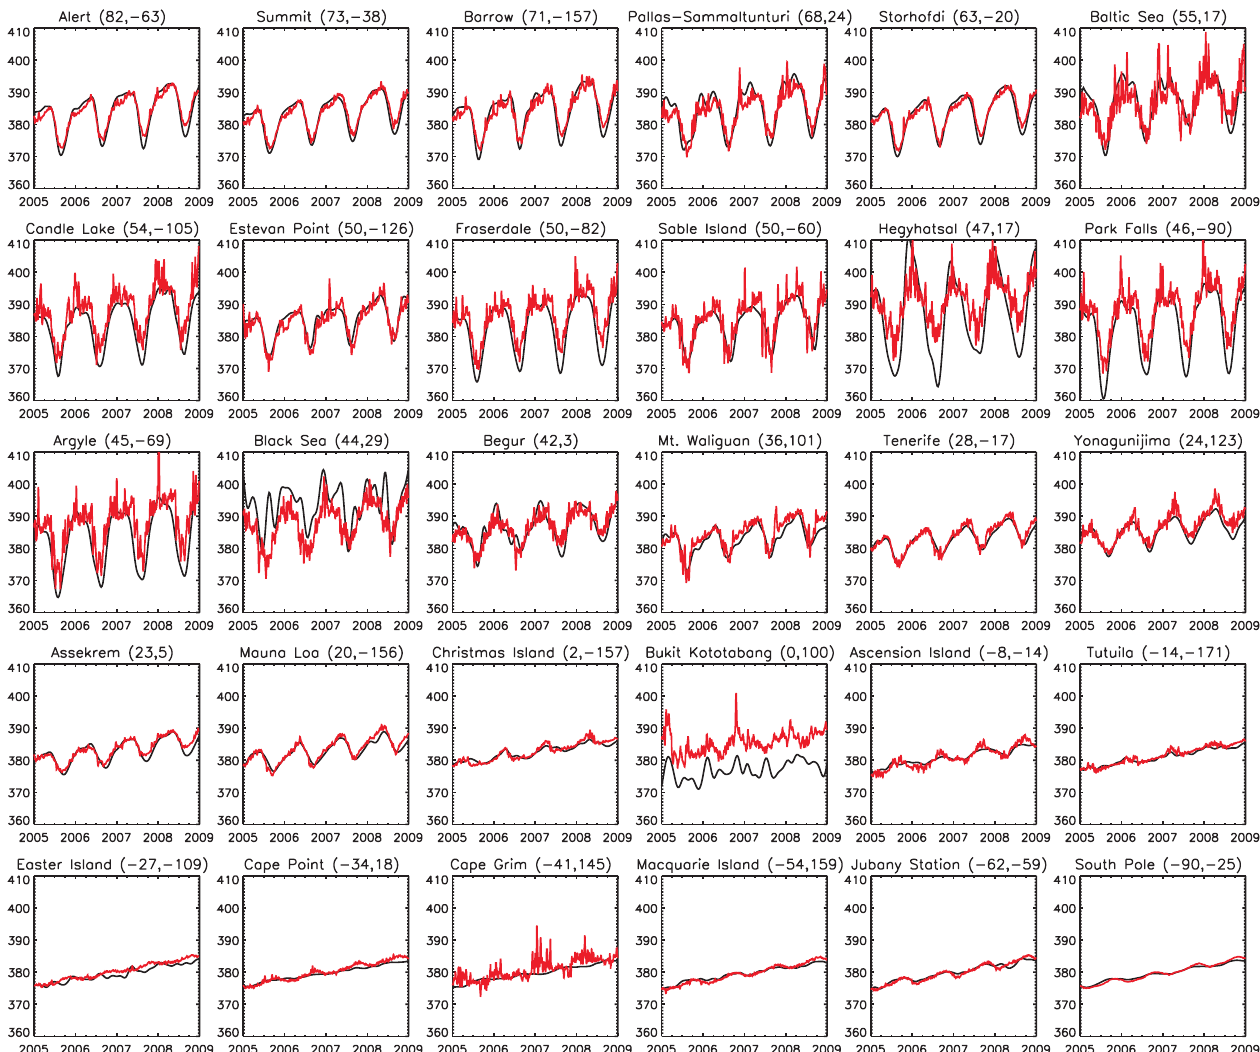
Fig. 13. 7-day averaged GEOS-Chem CO 2 with the chemical source on (red) compared with GLOBALVIEW-CO 2 smoothed ∼ 7 . 6- day average (black) at 30stations ranging from 90 ◦ S–82 ◦ N. The run began with a spin-up from globally-uniform CO 2 at 375ppm on 1 January